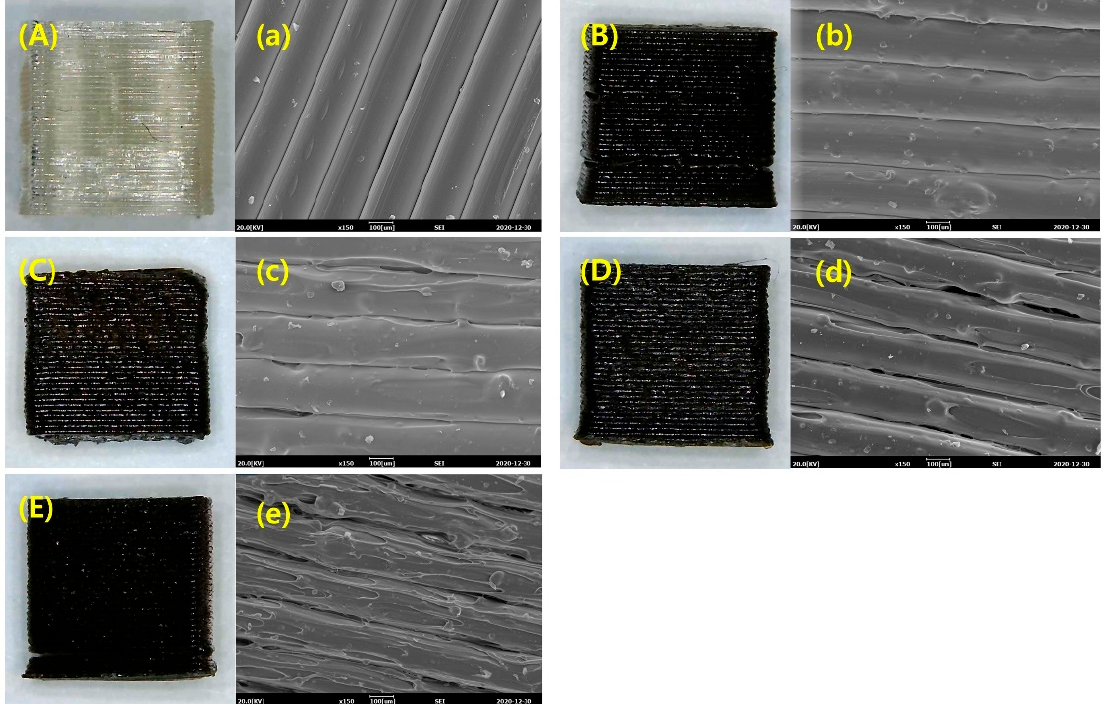
Figure 6. Optical image and side-view SEM micrographs of 3D printed objects fabricated by pure PLA ( A , a ) and PLA-based biocomposites with COOH-lignin contents of 5 wt.% ( B , b ), 10 wt.% ( C , c ), 15 wt.% ( D , d ), and 20 wt.% ( E , e ), respectively.